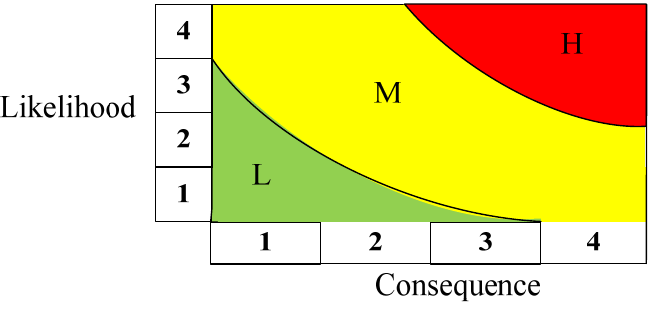
Figure 4. The continuous risk matrix.